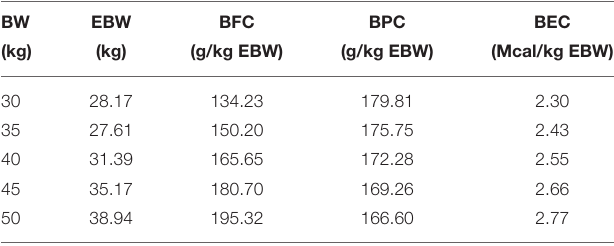
TABLE 3 | Body fat, protein, and energy contents of intact male Dorper × Santa Ines lambs from 30 to 50kg BW.